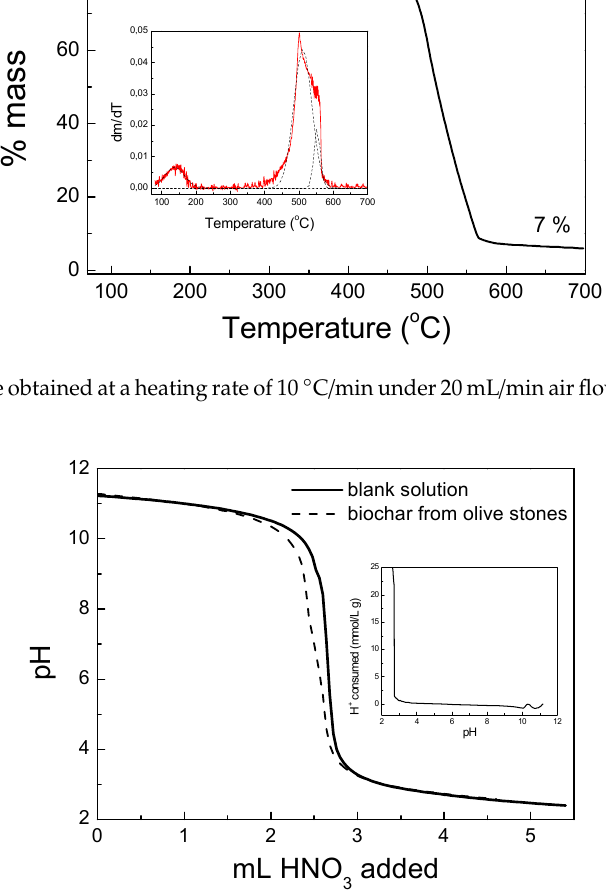
Figure 1. TGA curve obtained at a heating rate of 10 °C/min under 20 mL/min air flow. Inset: Differential TGA graph.